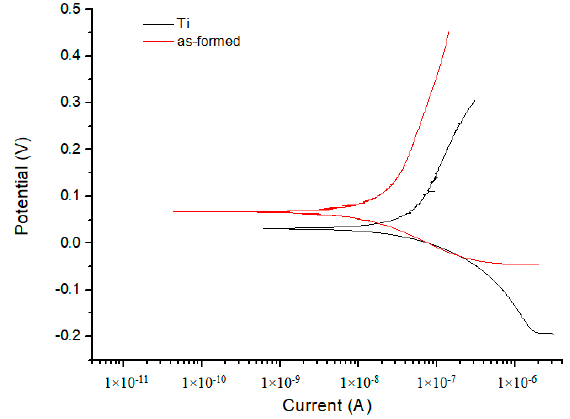
Figure 13. The corrosion behaviors of the uncoated sample and anodized sample.